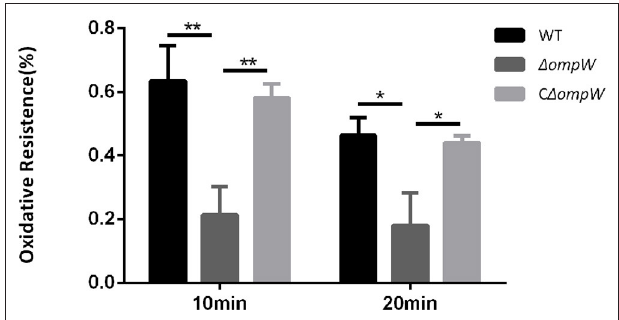
FIGURE 4 | Impaired oxidative stress tolerance of the A. pleuropneumoniae strain, the 1 ompW mutant strain, and the C 1 ompW strain. Overnight cultures were inoculated into fresh TSB supplemented with 10% FBS and 10 µ g/mL NAD and grown to an OD 600 value of approximately 0.6. Cells were then treated with 1mM hydrogen peroxide for 10min or 20min, respectively. The experiment has at least three biological repetitions. Results are expressed as means ± SD of three independent experiments. ‘*’ indicates significance at p < 0.05 and ‘**’ indicates significance at p < 0.01.